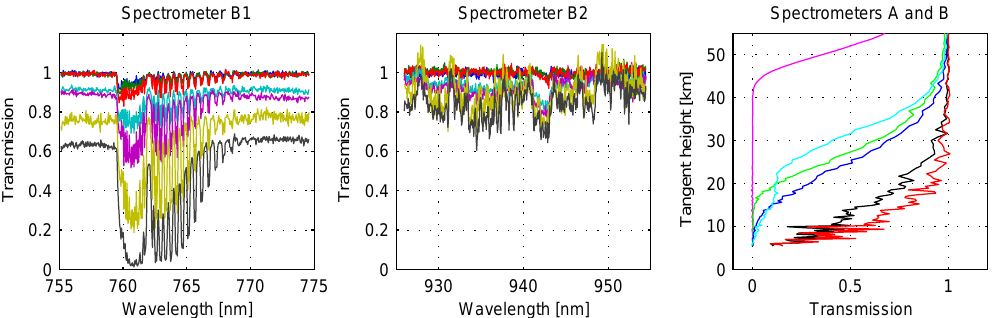
Figure 4. Examples of spectra (27 September 2004, 21.17 ◦ S, 48.62 ◦ E) for SPB1 (left) and SPB2 (middle) at tangent altitudes of (roughly) 15, 20, 25, 30, 35, 40 and 45km (from bottom to top). Right panel: tangent altitude profiles of GOMOS transmittance for spectrometer A: 300 (magenta), 400 (green), 500 (blue), 600nm (cyan); spectrometer B1 (black); B2 (red); the B1 and B2 profiles are very rough estimates of what can be expected; they are median values of the wings left and right of the B1 oxygen band, and the entire B2 spectrum